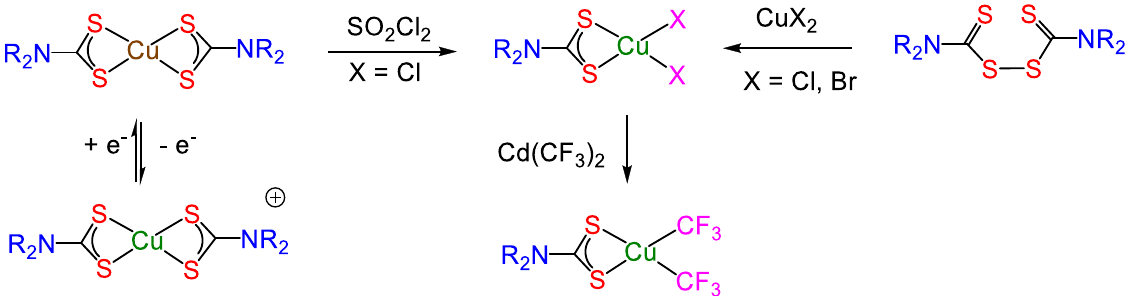
Figure 10. Synthetic routes to Cu(III) dithiocarbamate complexes.